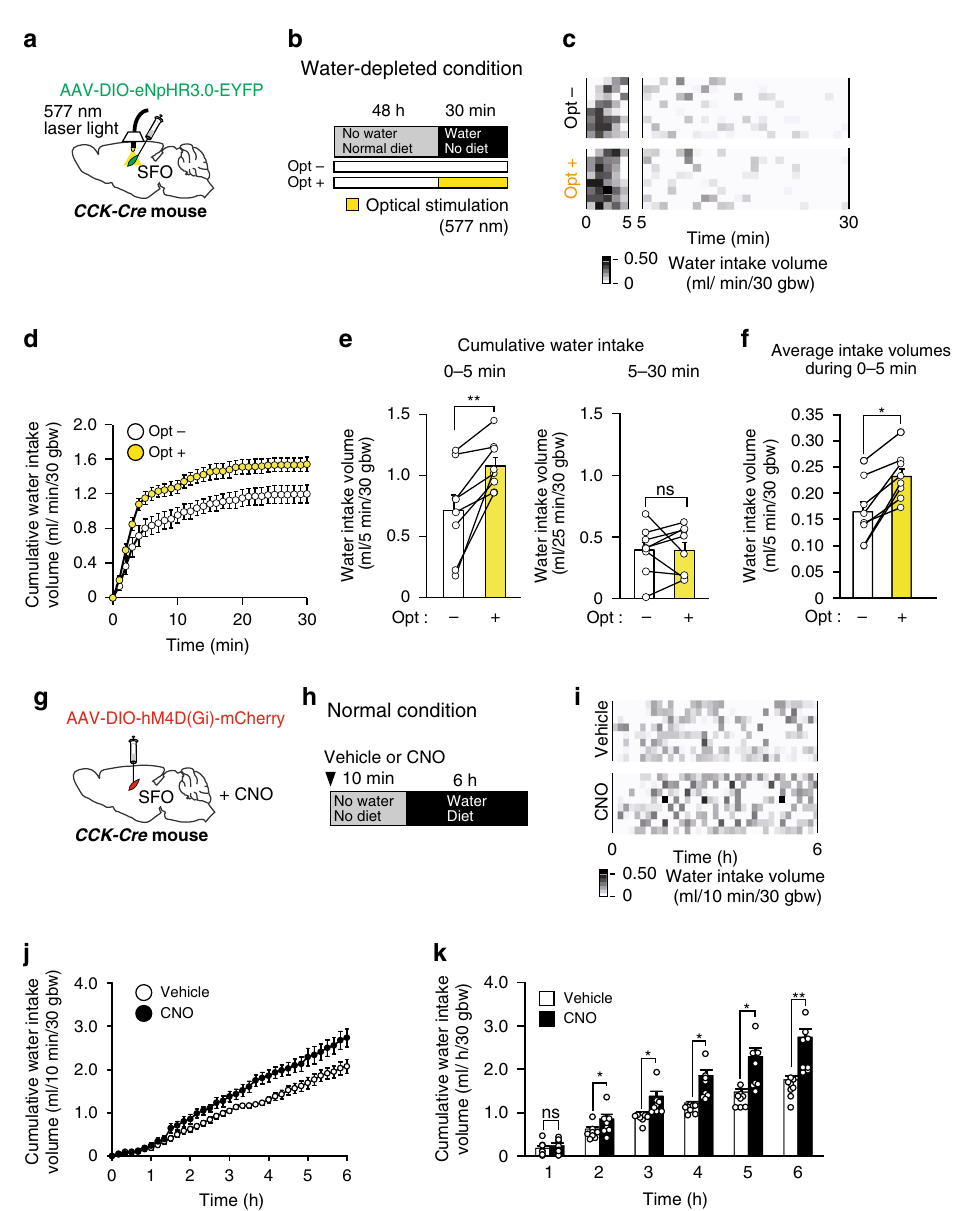
Fig. 7 Optical and chemogenetic silencing of CCK-positive SFO neurons enhances water drinking under both water-depleted and water-repleted conditions. a Injection of AAV-DIO-eNpHR3.0-EYFP into the SFO of the CCK-Cre mouse. b Experimental protocol to estimate water intake under the water-depleted condition with (opt + ) or without (opt – ) optical inactivation (wavelength, 577 nm). c Grayscale heat maps of water intake by individual mice with or without optical inactivation. 0 – 5 min (left), 5 – 30 min (right). d Water-intake volumes during 30 min with or without optical inactivation. e Summary of water intake under the water-depleted condition with or without the optical silencing of CCK-positive neurons in the SFO ( n = 8 mice each; W = 0, P = 0.008; W = 16, P = 0.834). 0 – 5 min (left), 5 – 30 min (right). f Averages of water intake volume with or without optical inactivation during (0) (5) 0 – 5 min ( W = 0, P = 0.0142). g Injection of AAV-DIO-hM4D(Gi)-mCherry into the SFO of the CCK-Cre mouse. h Experimental protocol to estimate water intake under the normal (free access to water and diet) condition with the subcutaneous injection of vehicle or CNO (2 mg/kg). i Grayscale heat maps of water intake by individual mice ( n = 8 mice each). j Water-intake volumes over 6 h with the vehicle or CNO injection. k Summary of cumulative water intakes in mice with the vehicle or CNO injection under the normal condition ( n = 8 mice each; W (1) = 10, P = 0.313; W (2) = 36, P = 0.014, W (3) = 0, P = 0.014; W (4) = 0, P = 0.014; W (5) = 1, P = 0.021; W (6) = 0, P = 0.008). Scale bar, 50 µ m. bw, body weight; ns, not signi fi cant; ** P < 0.01; * P < 0.05; two- sided Wilcoxon ’ s signed-rank tests in ( e ), ( f ), and ( k ). Data represent the mean ±